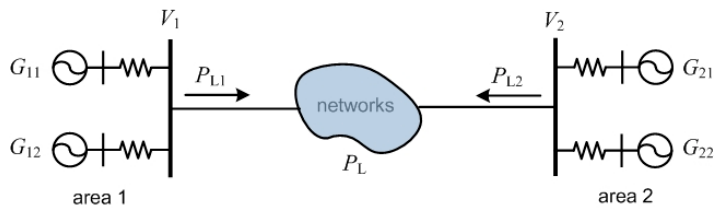
Figure 4. Local and wide area network.